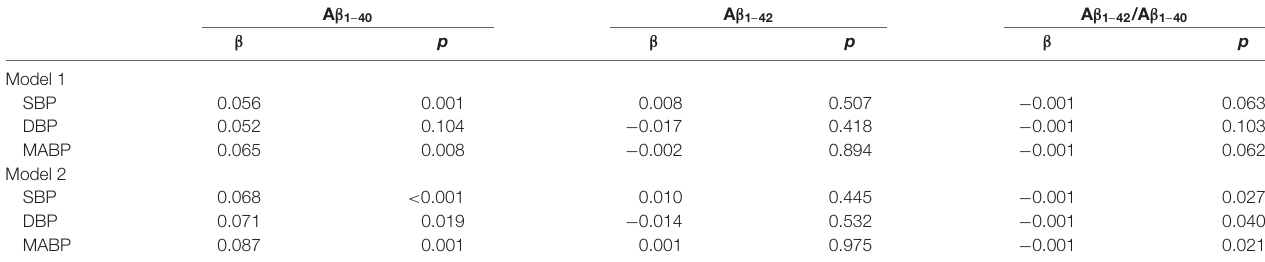
TABLE 2 | Multiple linear regression models analysis of blood pressure components and plasma A β 1–40 , A β 1–42 , and A β 1–42 /A β 1–40 ratio in total study